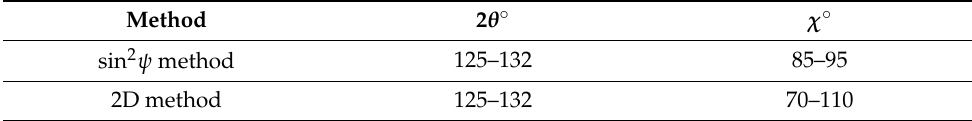
Table 3. Analyzed area of obtained X-ray diffraction.